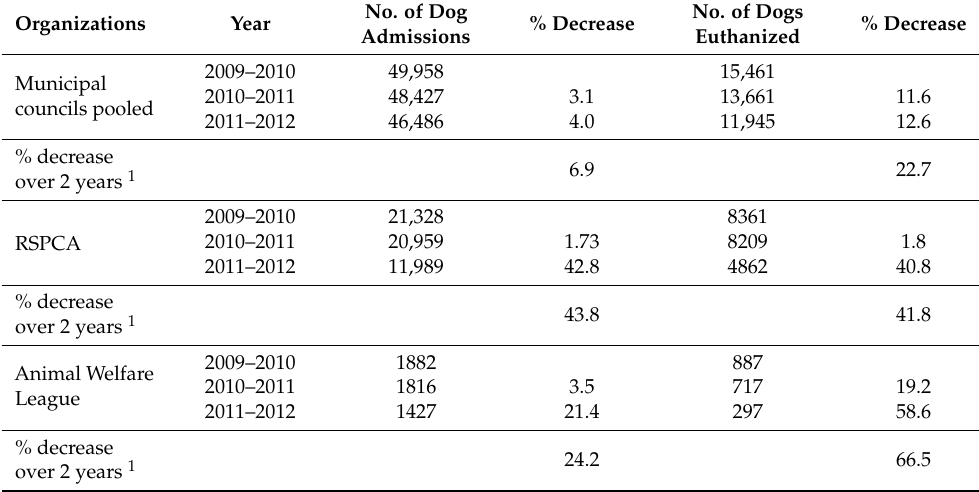
Table 2. Numbers of dog admissions to municipal councils, RSPCA and Animal Welfare League